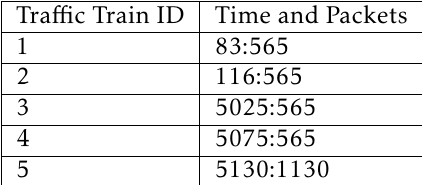
Table 2. The parsed outgoing traffic train set.